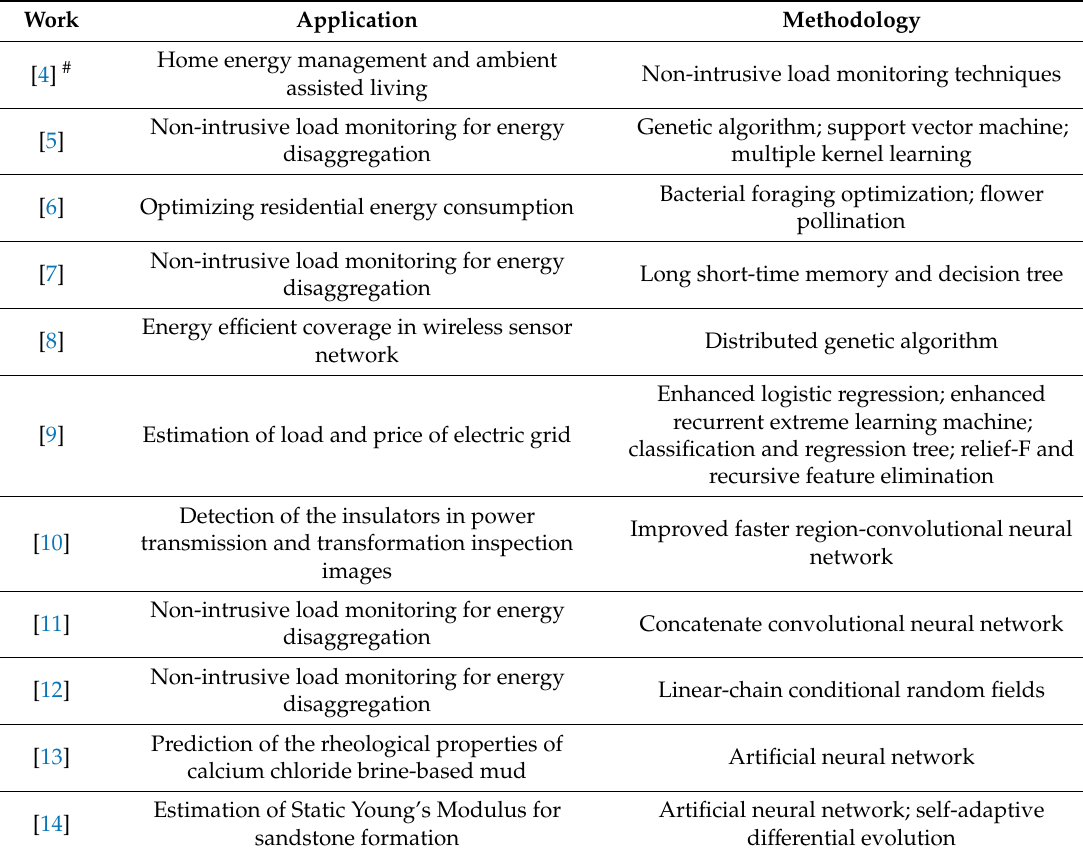
Table 1. Summary of the application and methodology of the special issue articles.